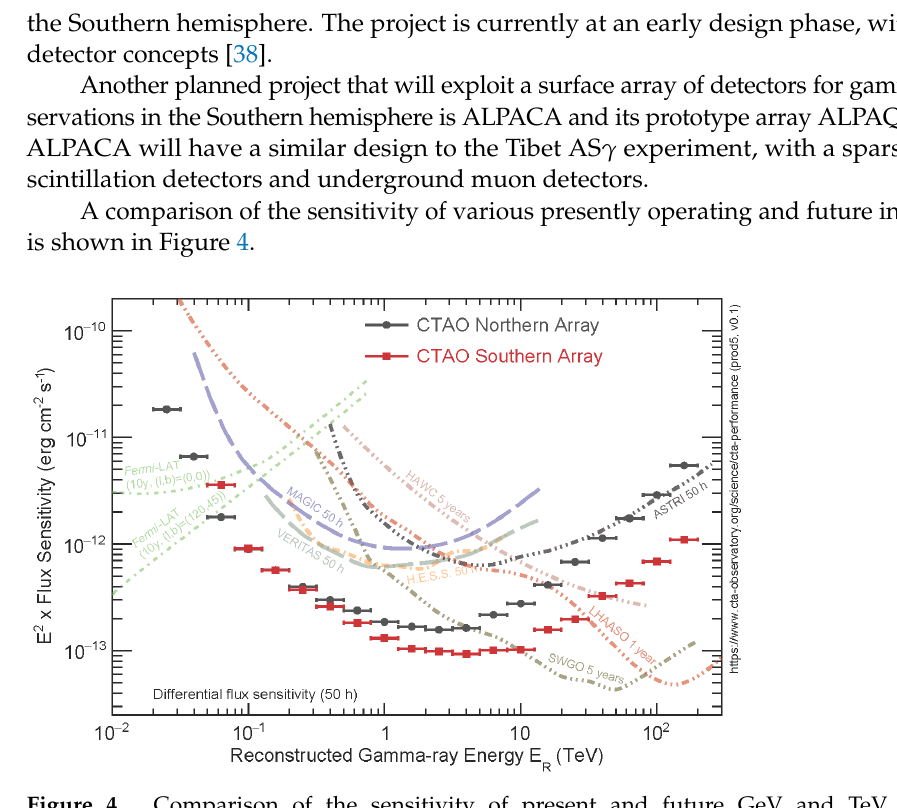
Figure 4. Comparison of the sensitivity of present and future GeV and TeV instrumen- tations: ASTRI [40], CTA [41], Fermi -LAT